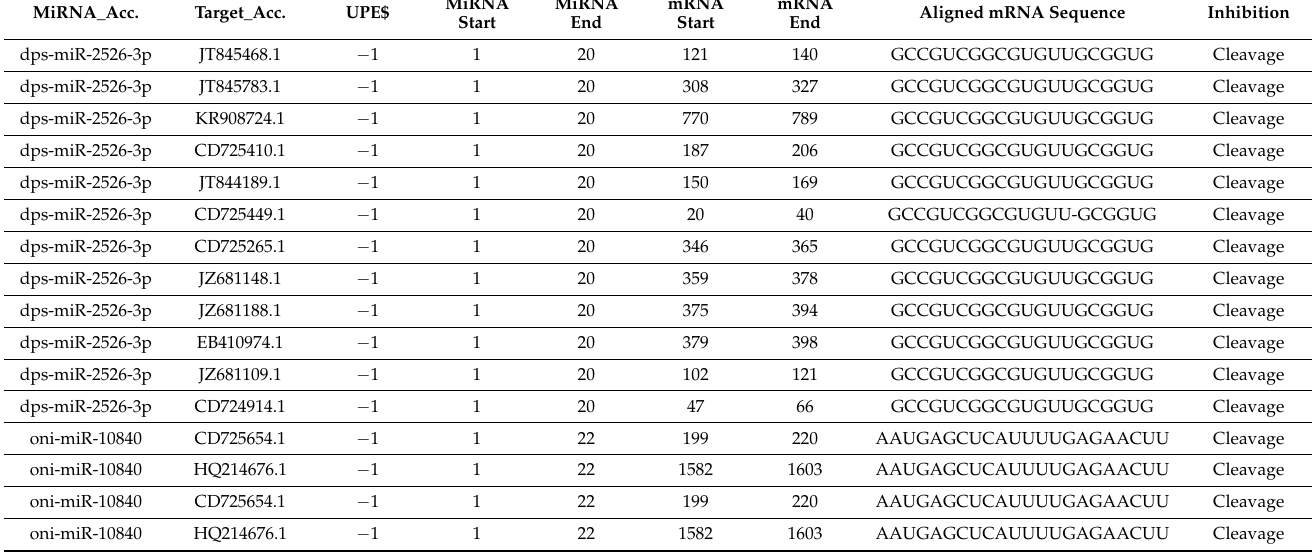
Table 6. Identified mRNAs for the